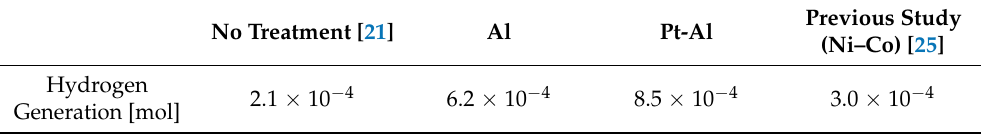
Table 1. Relationship between each processing condition and the total hydrogen generation